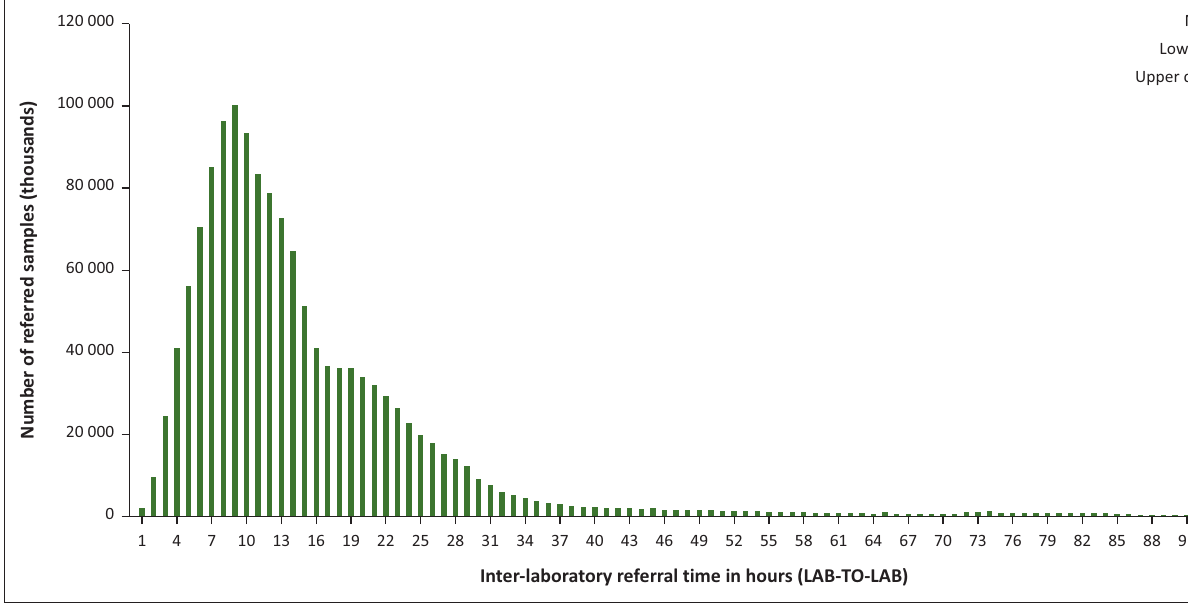
FIGURE 1: Distribution of inter-laboratory CD4 testing referral laboratory-to-laboratory turn-around time in the 2018 calendar year for National Health Laboratory Service laboratories in South Africa. Median, interquartile range, mode and range are indicated